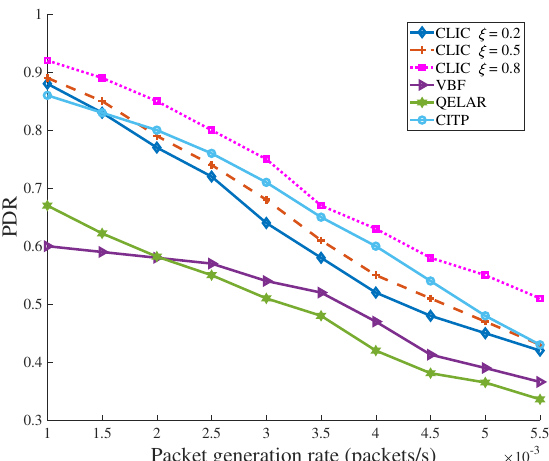
Figure 13. Comparison of PDR versus packet generation rate.